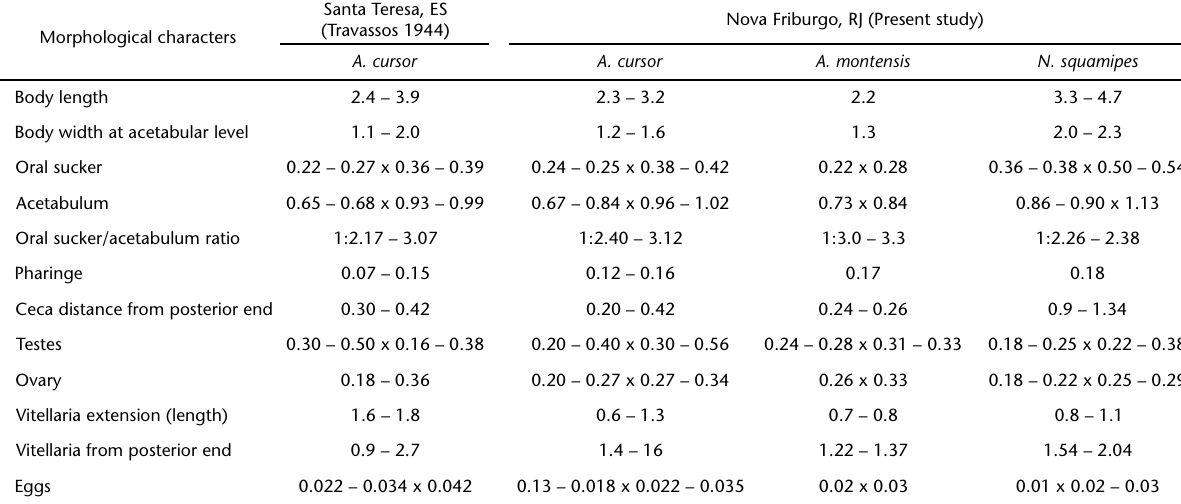
Table II. Morphometric comparison of C. obesa obtained from A cursor , A. montensis and N. squamipes from Nova Friburgo, Rio de Janeiro and C. obesa from A. cursor from in Santa Teresa, Espírito Santo according T RAVASSOS (1944). Morphological